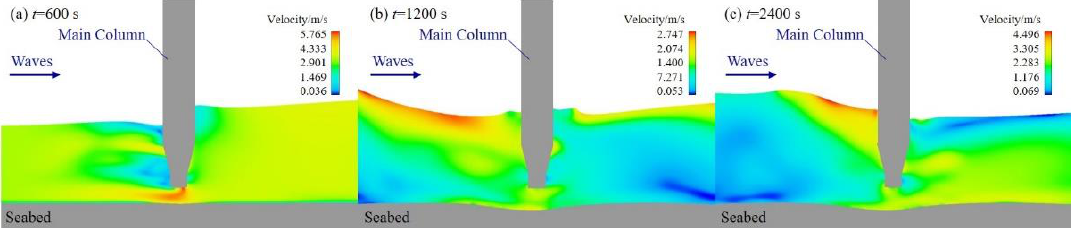
Figure 8. Flow velocity distribution around a tripod in the x - z section.